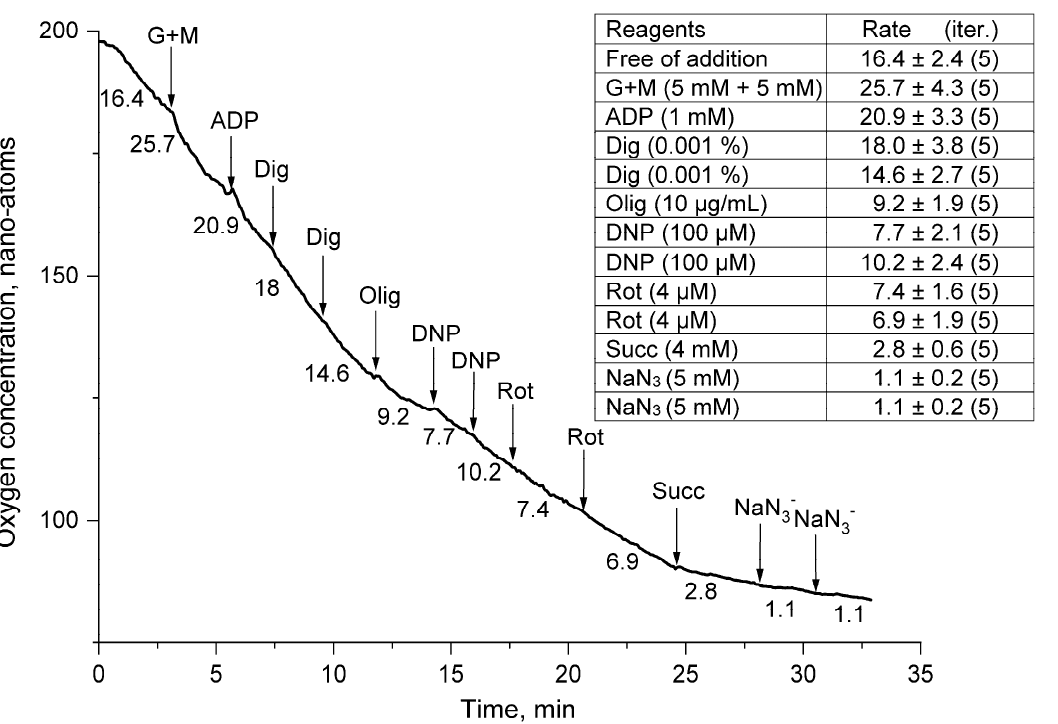
Figure 3. Rates of oxygen uptake by a suspension of thornback ray erythrocytes in the presence of oligomycin. The medium, additives, and designations are the same as in Figure 2. The oligomycin supplement (Olig) was 10 µg/mL.